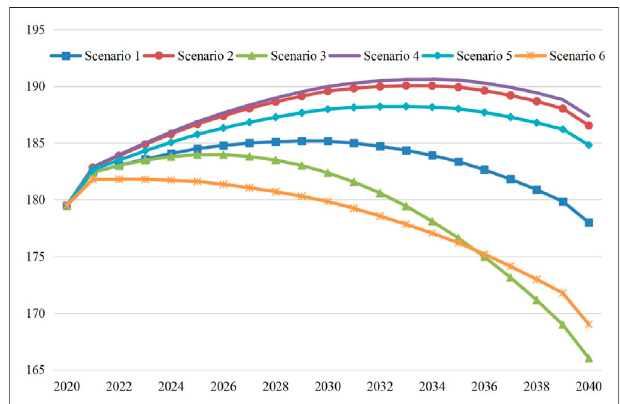
FIGURE 2 | Projected carbon dioxide emissions in six scenarios (100 million